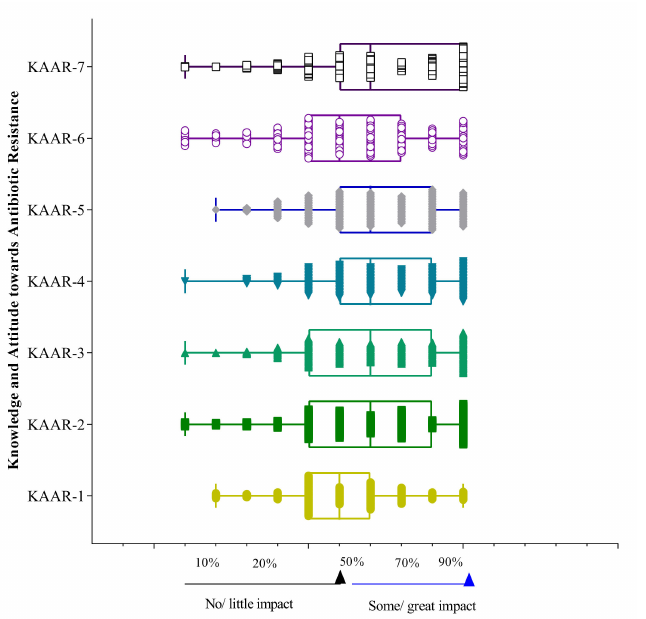
Figure 7. Scores of perceptions of knowledge and attitude towards antibiotic resistance, and impact of different factors have on antimicrobial resistance. Data are presented as percentiles where <50% means no or little impact whereas >50–70% indicates some impact and >70% indicates a great impact. Note KAAR-01, few antibiotics being developed; KAAR-02, prescribing antibiotics when the situation does not warrant their use; KAAR-03, using the wrong antibiotic for the situation; KAAR-04, using an inappropriate dose and/or frequency of an antibiotic for the situation; KAAR-05, using antibiotic treatment for a longer duration than indicated; KAAR-06, not prescribing antibiotics when the situation requires their use; KAAR-07, patient noncompliance with antibiotic therapy (such as not taking the medication as prescribed, not completing the course, or taking too much).